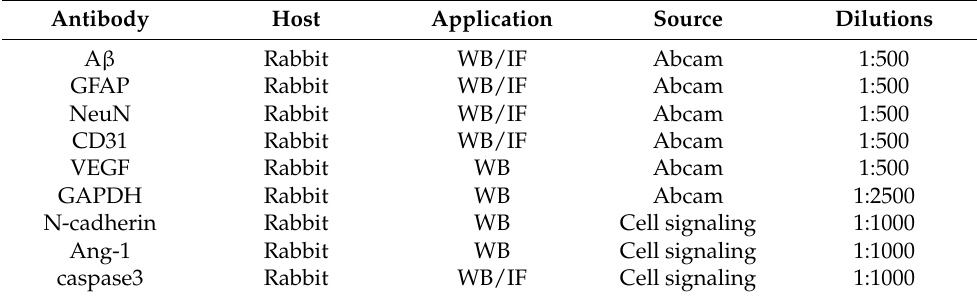
Table 1. Antibody